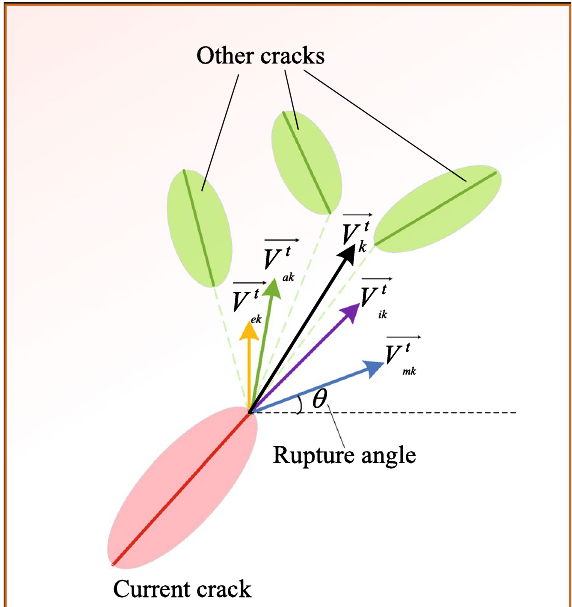
−→ V t is the inertial direction, ik